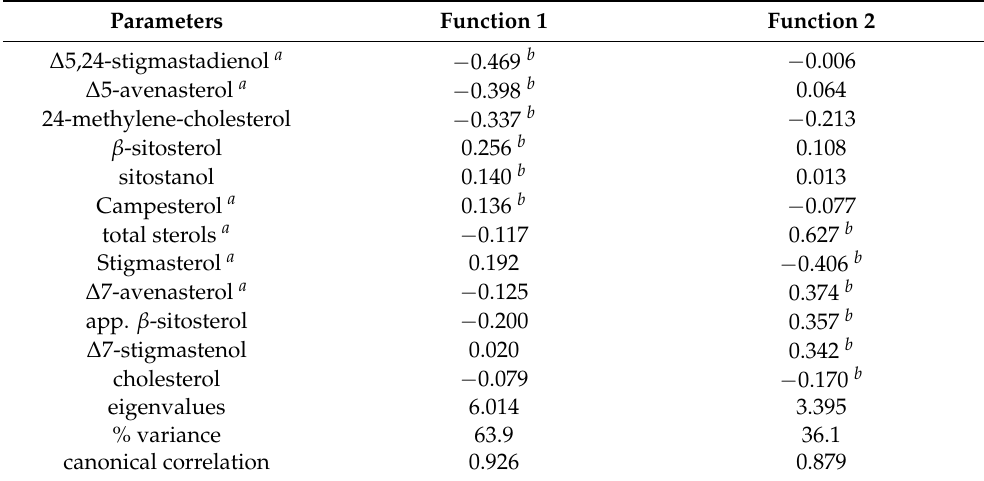
Figure 4. Canonical discriminant functions biplot and centroids of crop years obtained from sterols composition. Table 8. Combined within-group correlations between discriminant variables and standardized canonical discriminant functions and